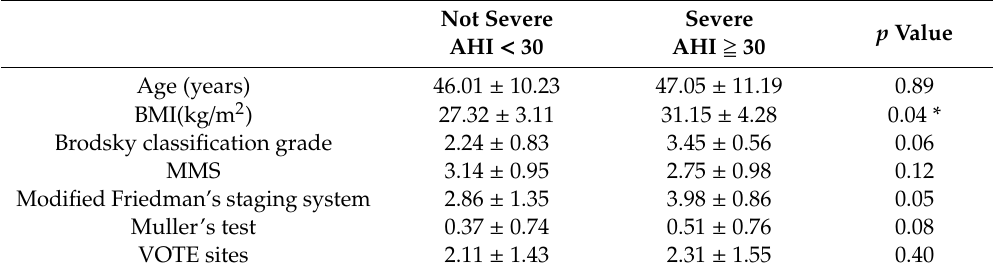
Table 1. Clinical characteristics between patients with not-severe and severe OSA.